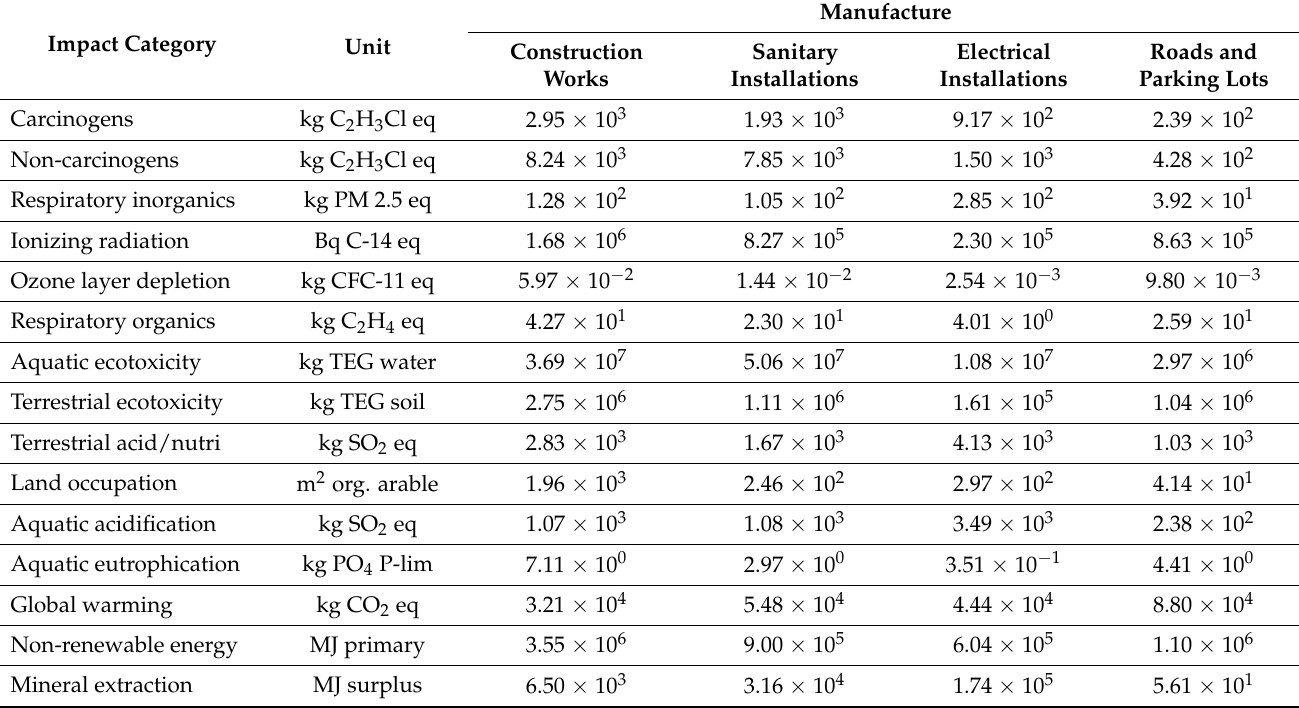
Table 4. The results of characterizing the environmental consequences occurring at the production stage of the research object by the groups of